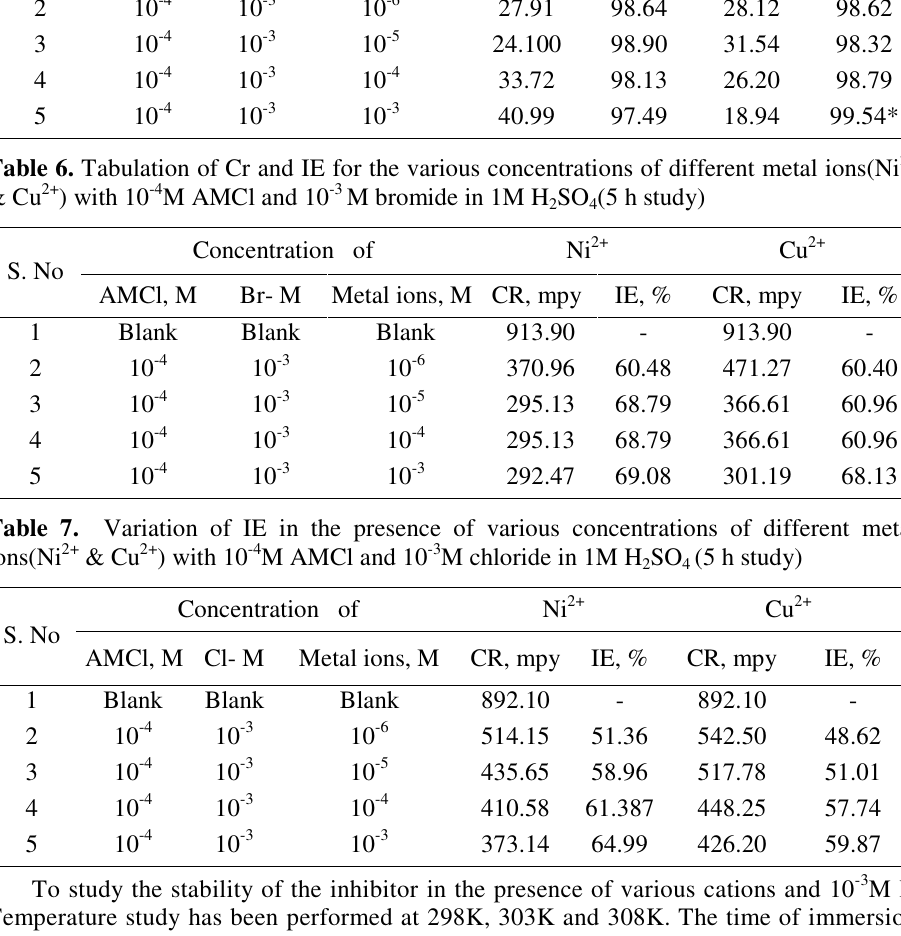
Table 5. Role of metal ions(Ni 2+ & Cu 2+ ) and iodide (10 -3 M) on the corrosion inhibition of MS in the presence of 10 -4 M AMCl in 1M H S. No.